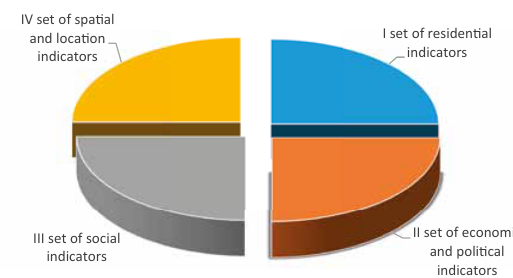
Fig. 4. Classification of data categories for “rating attributes toolkit” Source : own